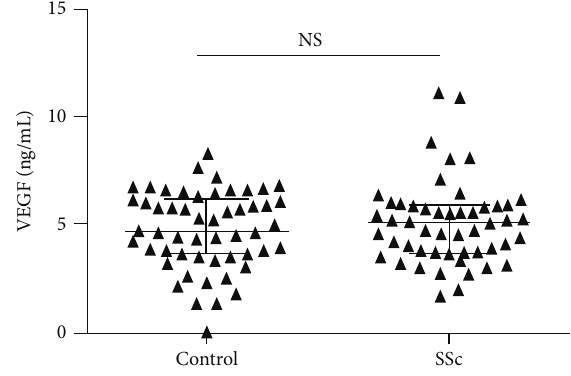
Figure 1: VEGF concentrations (ng/mL) in tears of healthy controls (left) and SSc patients (right).